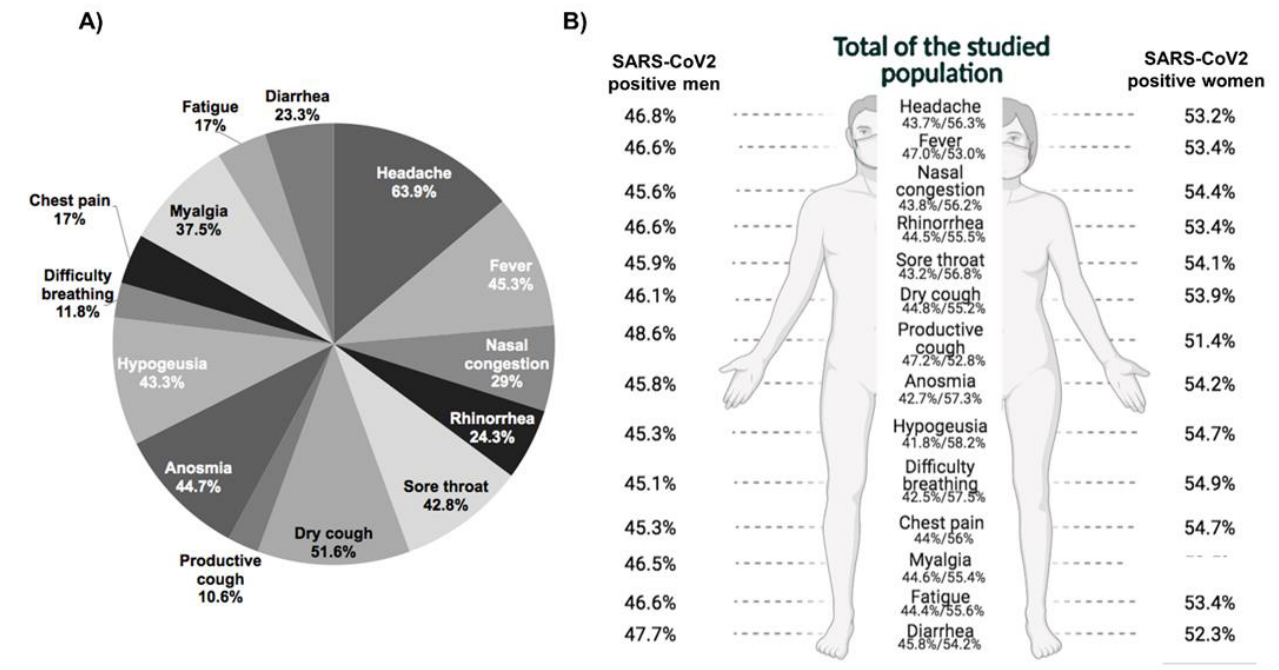
Figure 3. The most common symptoms reported related to COVID-19. ( A ) Symptoms reported by all of the studied population, each slice represents the proportion of the reported. The most common symptoms were: headache, dry cough, and fever. ( B ) Information segregated by sex, values in the middle represent the total of the studied population separated by sex. The proportions shown in both edges constitute only the confirmed cases segregated by sex. In the confirmed cases, more women reported having symptoms than men.